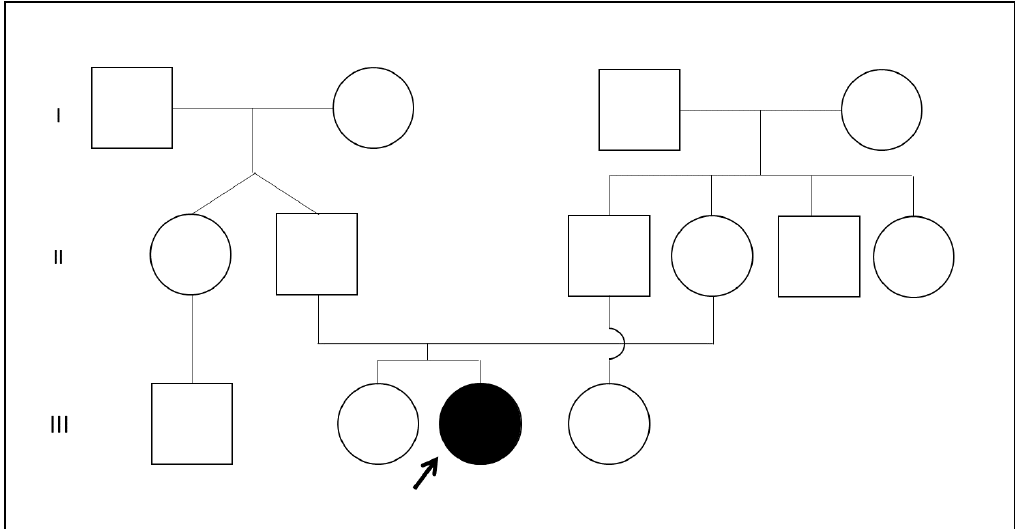
Figure 2. Family pedigree of our